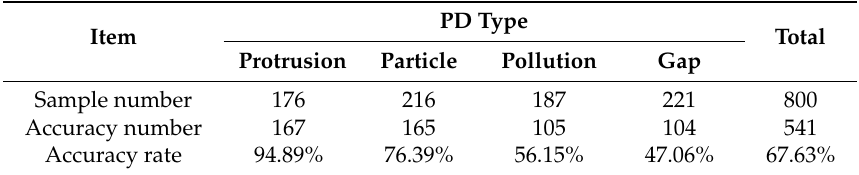
Table 7. Recognition result using the concentrations of SF 6 decomposed components as the input matrix.